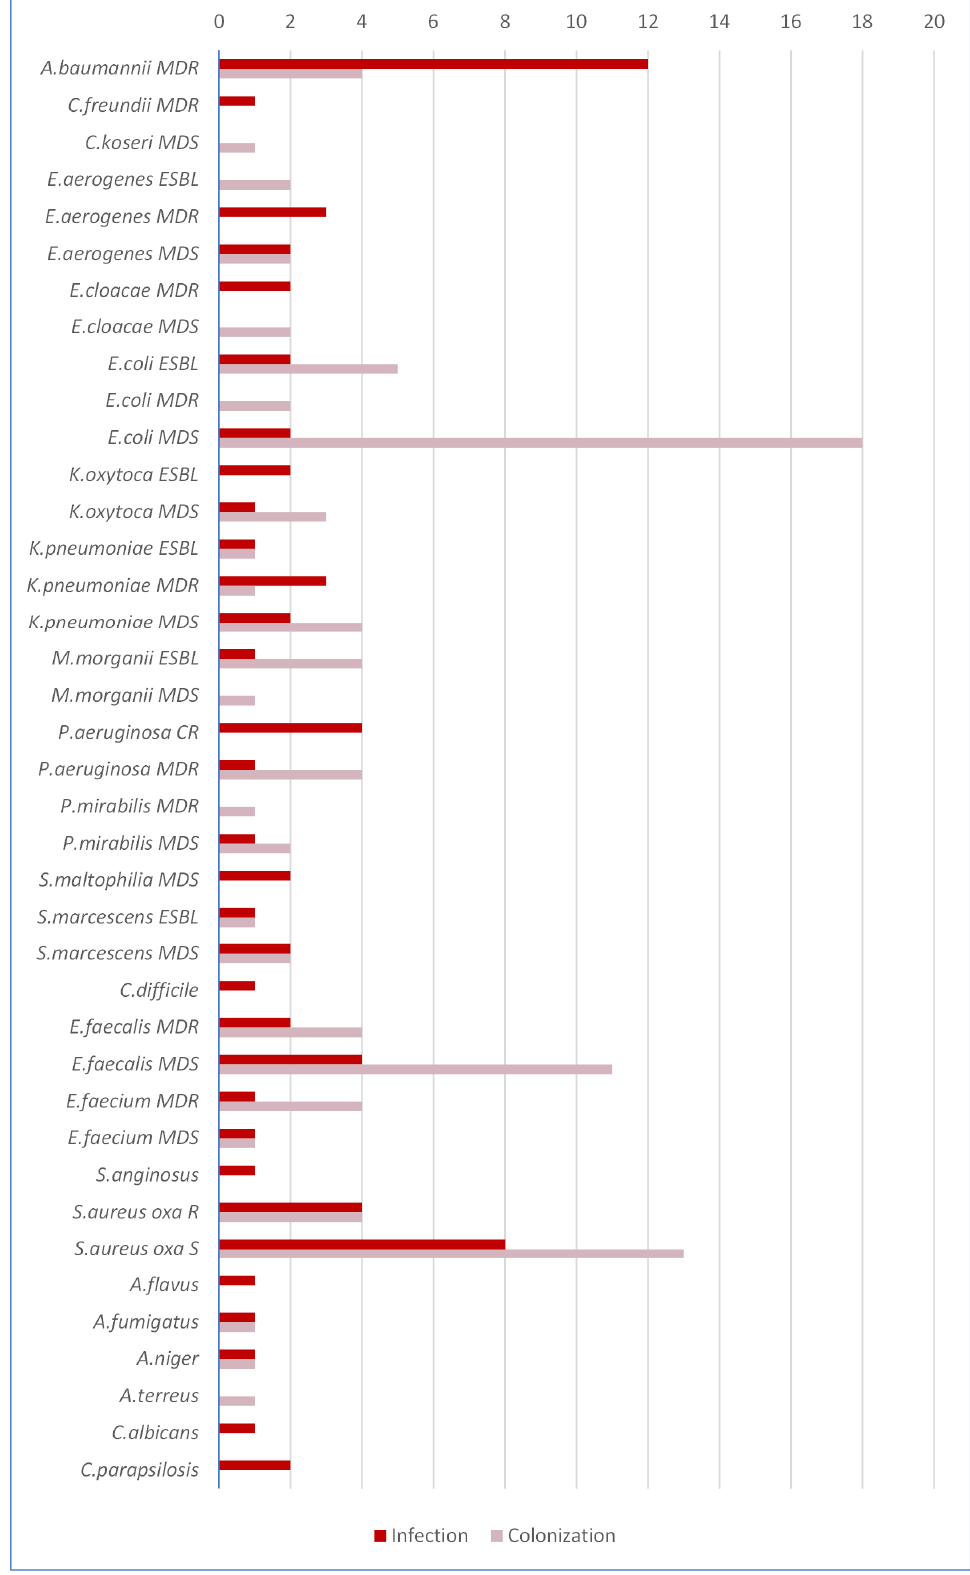
Figure 2. Isolates recovered from COVID-19 patients. S, Susceptible; MDR, Multi-Drug-Resistant; R, Resistant; MDS, Multi-Drug-Susceptible; ESBL, Extended Spectrum-Beta-Lactamase; CR, Carbapenem-Resistant.